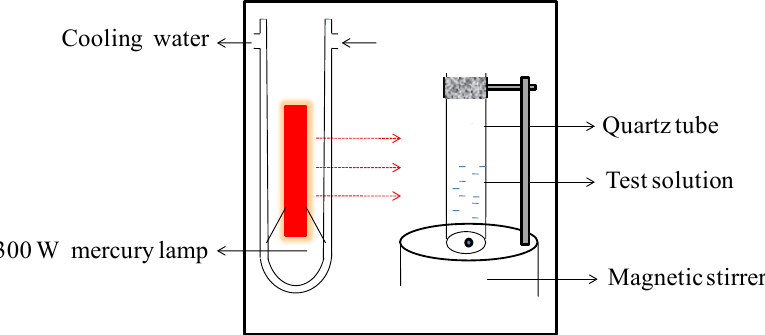
Figure 1. The apparatus for photoactivity performance testing.